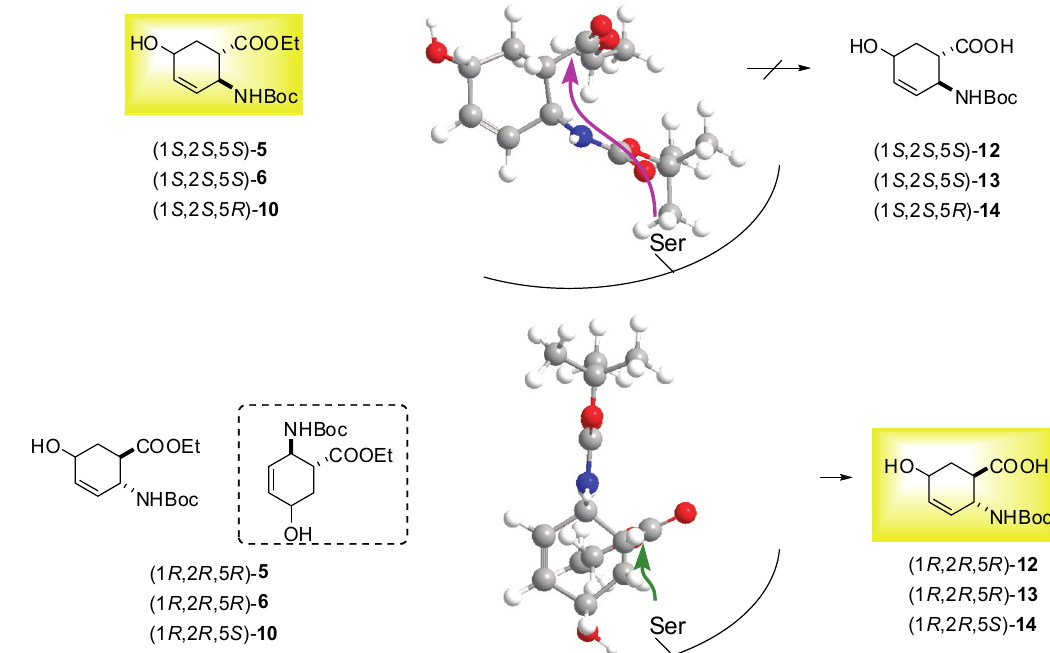
Figure 3. R -selective hydrolysis of (1 S *,2 S *,5 S *)-( ± )- 5 , (1 S *,2 S *,5 S *)-( ± )- 6 and (1 S *,2 S *,5 R *)-( ± )- 10